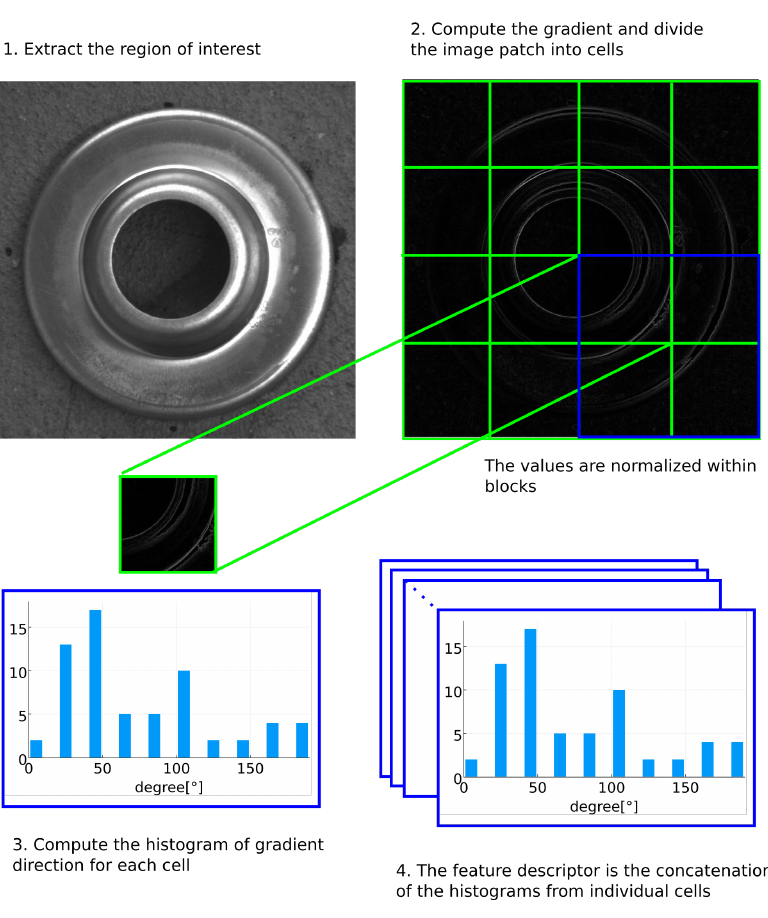
Figure 8. Histogram of oriented